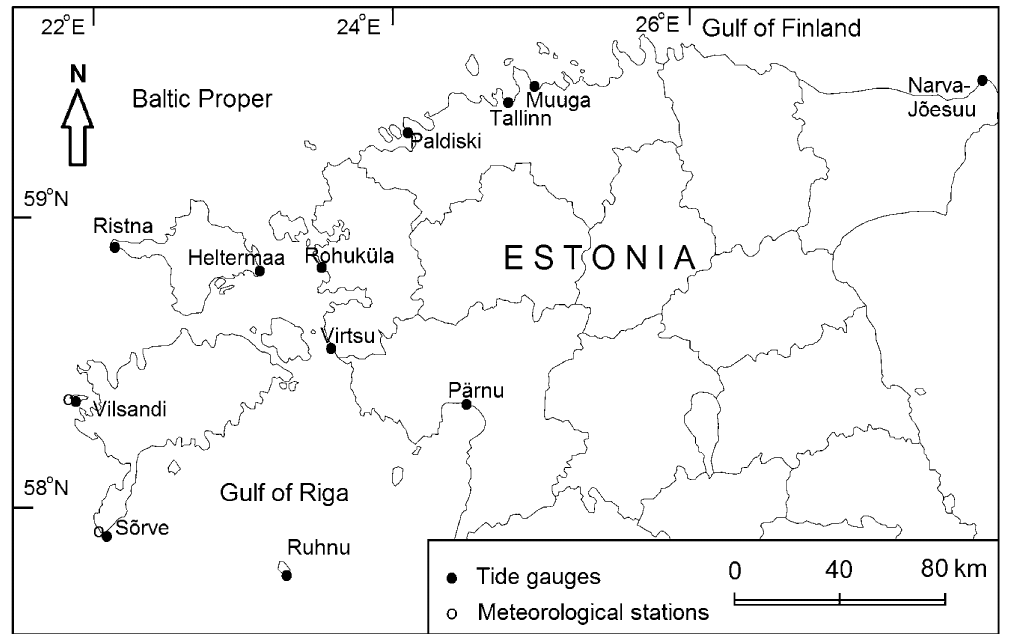
Fig. 1. Map of the study area with the observation